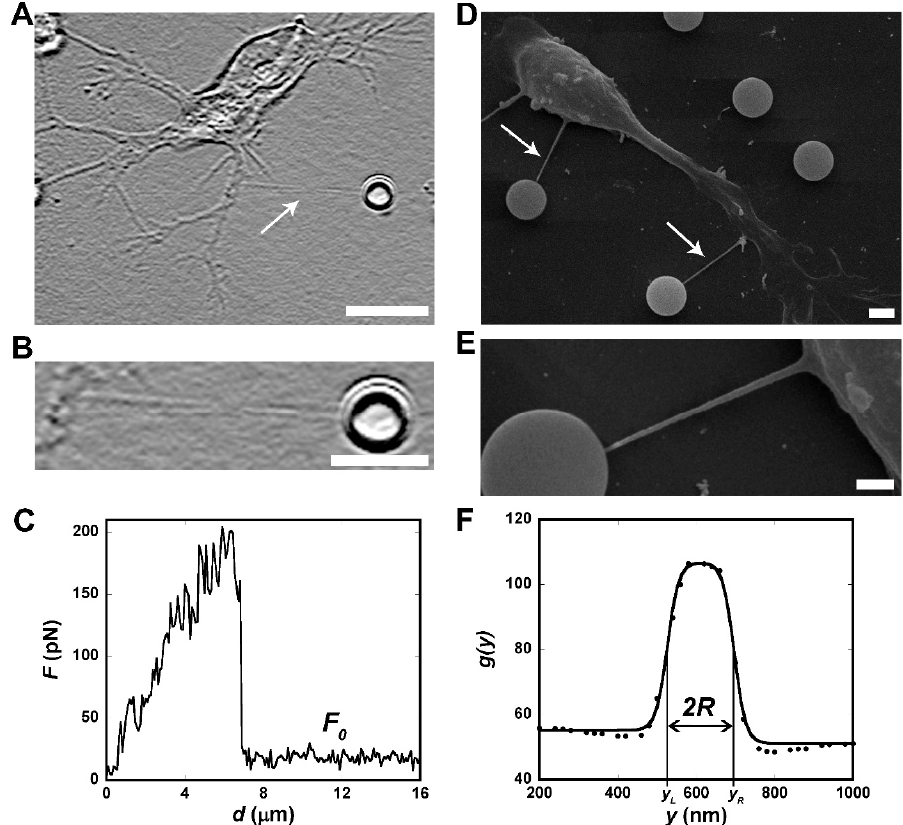
Figure 1. Typical tether force and radius measurements. ( A ) Representative bright field image of a membrane tether extracted from a cell cultured for 48h in Neurobasal medium (indicated by a white arrow). ImageJ shadow north processing filter was applied to better visualize the tether. ( B ) Zoom of the tether in A. Scale bar for A is 10 µ m and for B is 5 µ m. ( C ) A representative curve of force F versus stage displacement d for a tether extraction experiment. F 0 is the steady-state tether force. ( D ) SEM representative image of tethers extracted from a cell cultured for 48h in Neurobasal medium. ( E ) Zoom of one of the tethers indicated by the white arrows in D. Scale bar for D is 2 µ m and for E is 1 µ m. ( F ) Grey level plot profile of the tether in